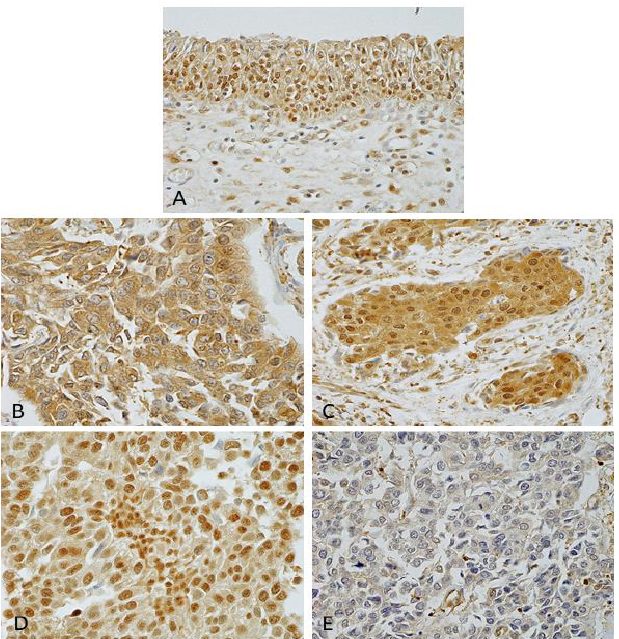
Figure 3. DJ-1 expression patterns in non-neoplastic urothelial cells and urothelial carcinoma. ( A ) Nuclear staining observed in non-neoplastic urothelial cells. ( B ) Cytoplasm-positive, nucleus-negative: Group 1. ( C ) Cytoplasm-positive, nucleus-positive: Group 2. ( D ) Cytoplasm-negative, nucleus-positive: Group 3. ( E ) Cytoplasm-negative, nucleus-negative: Group 4. All 400× original magnification.